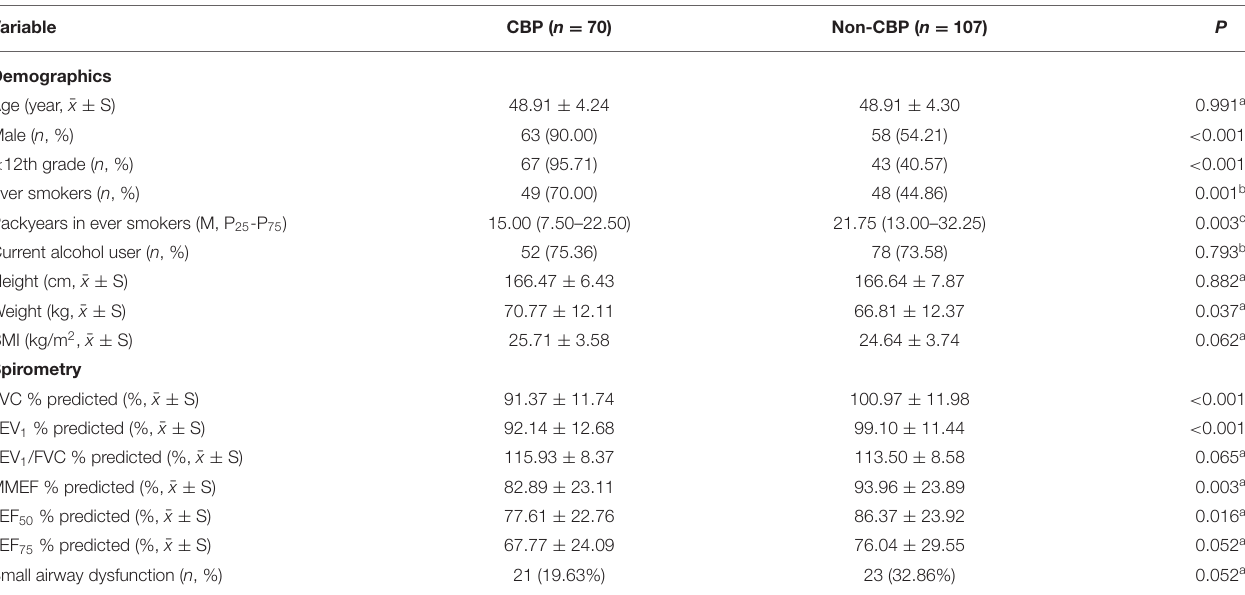
TABLE 1 | General characteristics in the study population ( n =